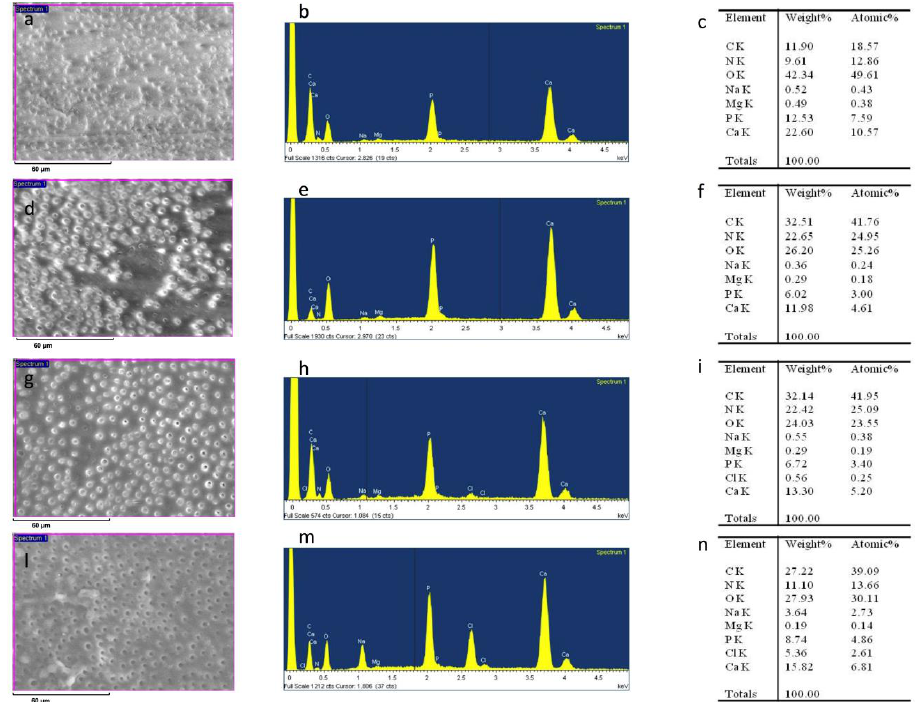
Figure 4: ESEM image, EDX spectra, and table of elements recorded on the dentin surface after sanding with abrasive paper ( a , b , c ), after treatment with a 10% citric acid solution ( d , e , f ), and after immersion in SBF for 24 h ( g , h , i ) and two months ( l , m , n ).